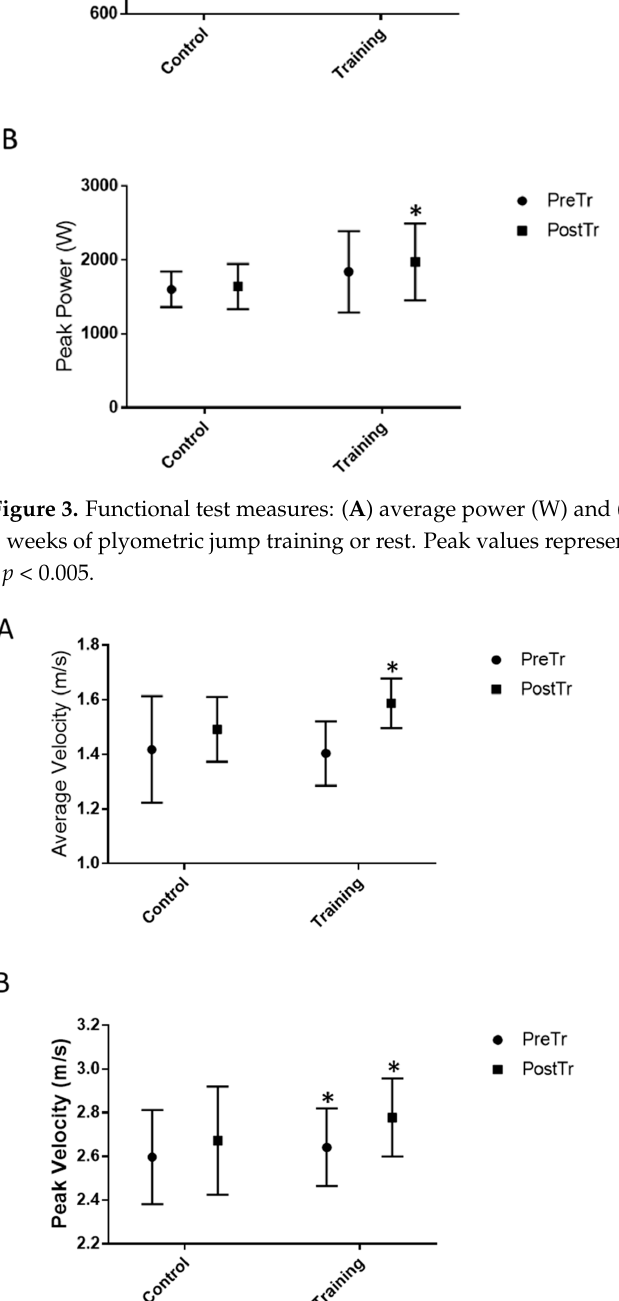
Figure 5. Functional test measures: jump height (cm) before and after 8 weeks of plyometric jump training or rest. Peak values represent the highest of the three test jumps. * p < 0.001. 3.3. Skeletal Muscle Fibres Adaptations No significant differences in the skeletal muscle fibre CSAs between groups and amongst individuals were found. Furthermore, no change in the skeletal muscle fibre